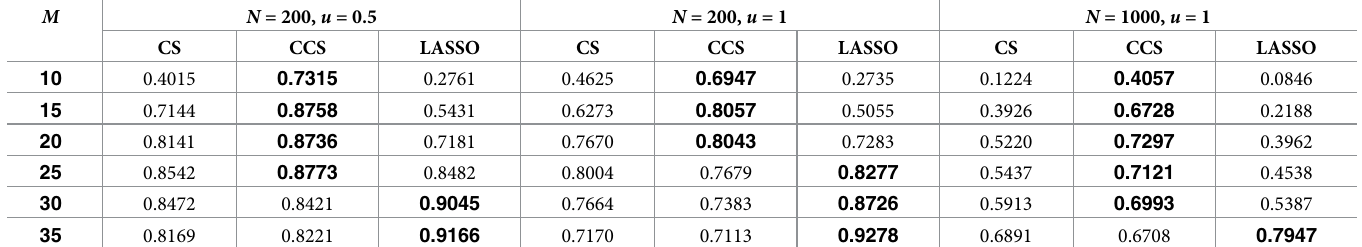
Table 7. The success rate of CS, CCS, LASSO in a noisy environment. M N = 200, u =